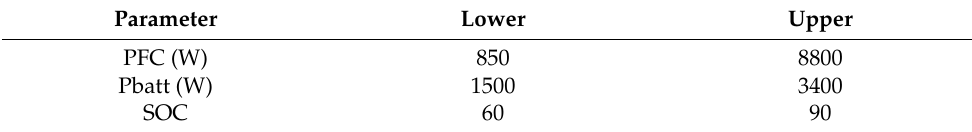
Table 3. lower and upper